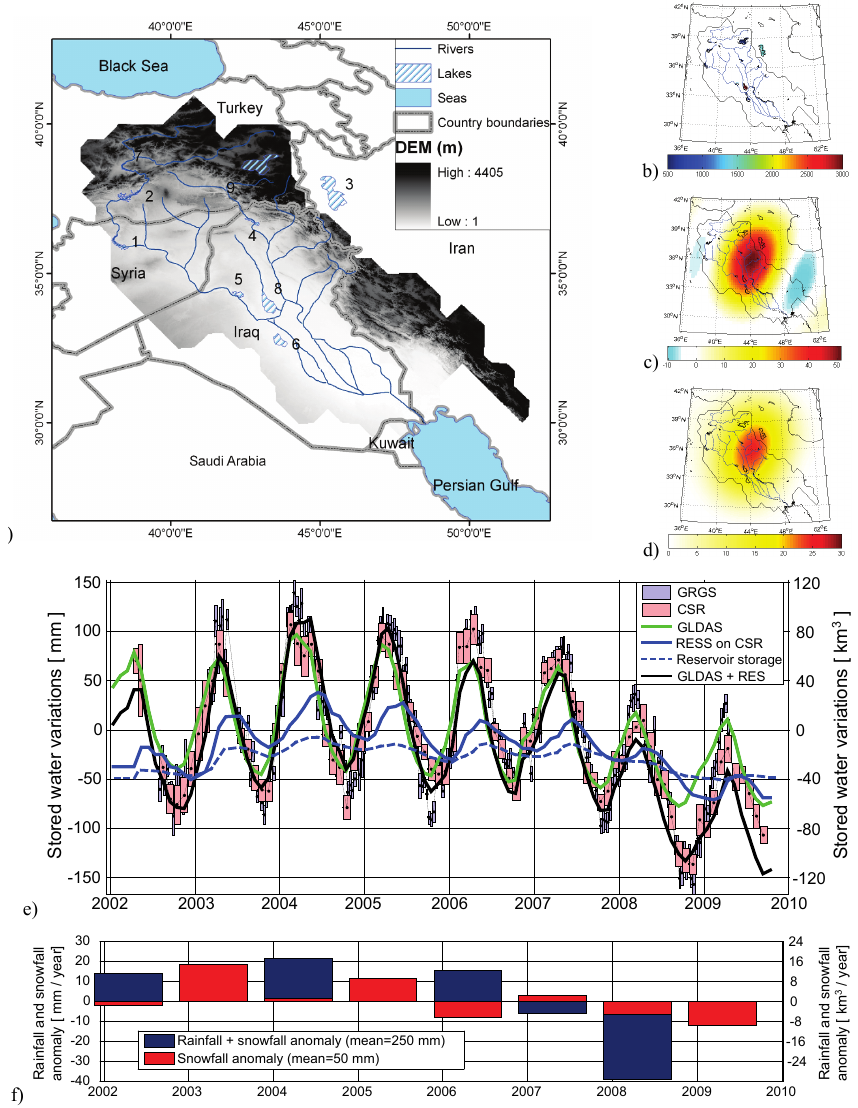
Fig. 4. (a) DEM and river network of the Tigris–Euphrates basin and location of the modeled lakes and reservoirs. (b) Reservoir distribution and standard deviation of lake level variations in mm for each of the nine Tigris–Euphrates reservoirs and lakes; (c) spatial distribution of reservoir impact on GRACE after hard truncation at degree 50 (similar to GRGS processing); (d) same as (c) but after truncation at degree 60 and 300km Gaussian smoothing (similar to CSR processing) (e) Water storage variations for the Tigris–Euphrates basin from GRACE GRGS and CSR, GLDAS SMS, predicted reservoir storage (RESS) impact on CSR and simple sum of reservoir storage changes distributed over the basin. (f) Rainfall and snowfall anomaly over the Tigris–Euphrates